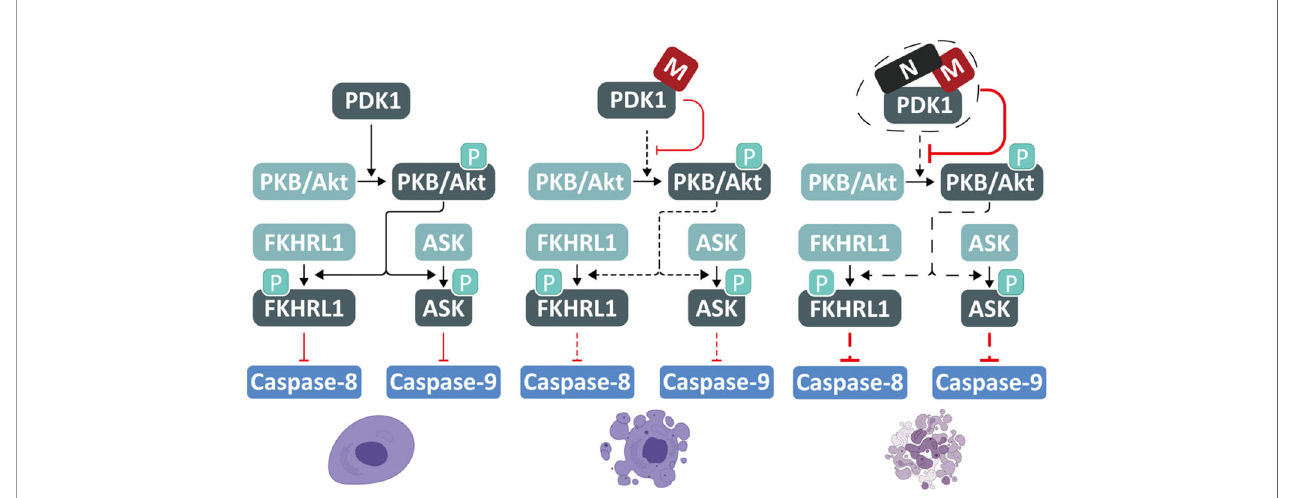
FIGURE 6 | A proposed model for SARS-CoV-2 M and N to induce apoptosis. SARS-CoV-2 M possesses a pro-apoptotic activity via interacting with PDK1 to attenuate PDK1-PKB/Akt interaction and signaling, while N acts as a scaffold for M and PDK1 to enhance the M-induced